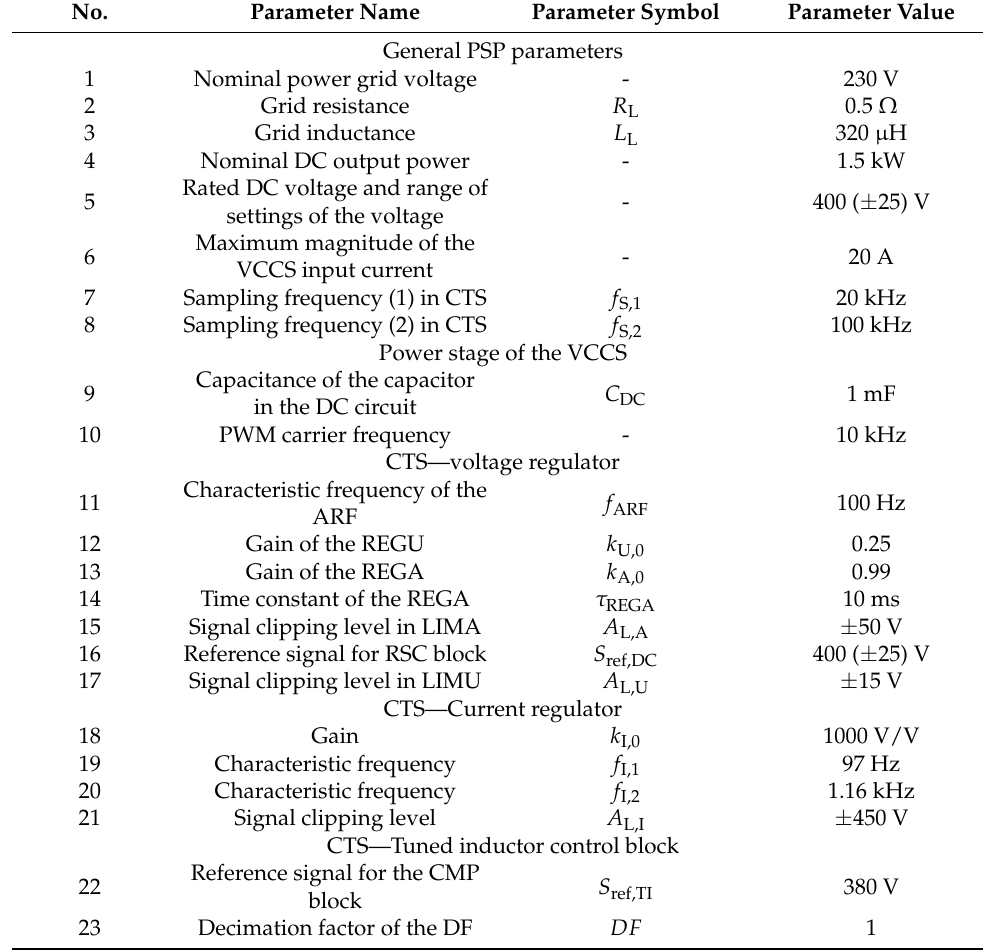
Table 1. List of Basic Parameters of the ES Laboratory